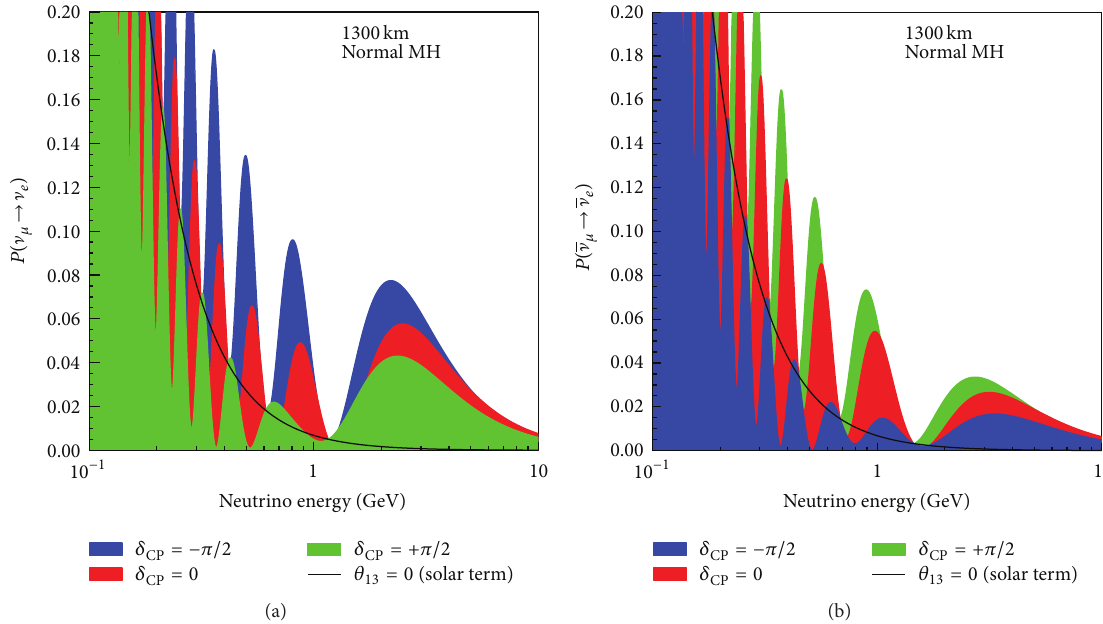
Figure 1: The appearance probability for ] 𝑒 (a) and ] 𝑒 (b) as a function of neutrino energy in a ] 𝜇 / ] 𝜇 beam. The curves are calculated for for the Daya Bay best fit value of 𝜃 13 and for 𝜃 13 = 0 . 1300 km baseline and NO, three values of 𝛿 CP